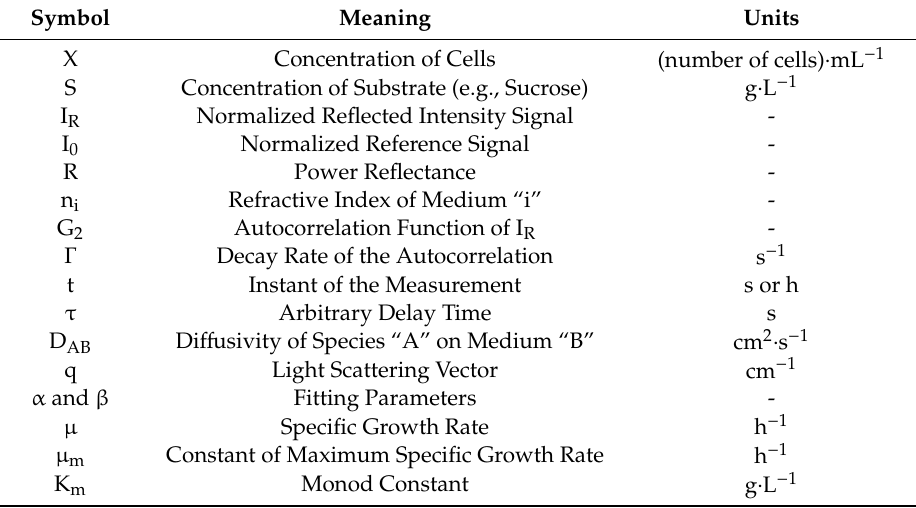
Table 1. Mathematical symbols given in the order they are introduced in this research. Symbol Meaning Units X Concentration of Cells (number of cells) · mL − 1 S Concentration of Substrate (e.g., Sucrose) g · L − 1 I R Normalized Reflected Intensity Signal - I 0 Normalized Reference Signal - R Power Reflectance - n i Refractive Index of Medium “i” - G 2 Autocorrelation Function of I R - Γ Decay Rate of the Autocorrelation s − 1 t Instant of the Measurement s or h τ Arbitrary Delay Time s D AB Di ff usivity of Species “A” on Medium “B” cm 2 · s − 1 q Light Scattering Vector cm − 1 α and β Fitting Parameters - µ Specific Growth Rate h − 1 µ m Constant of Maximum Specific Growth Rate h − 1 K m Monod Constant g · L −